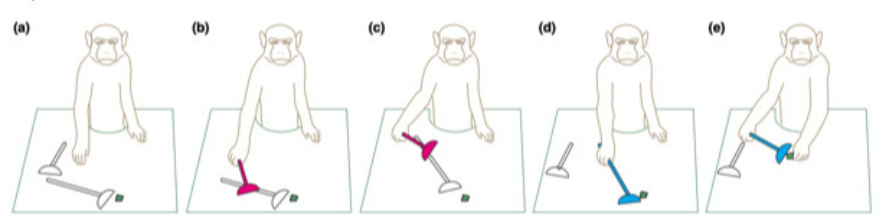
Fig. 2 Figure from Maravita, A., & Iriki, A. (2004). Tools for the Body (Schema). Trends